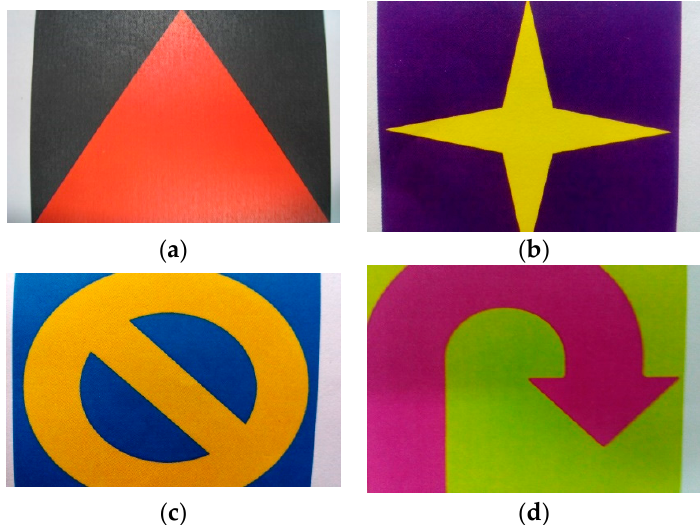
Figure 2. Predefined signs serving as motion commands: ( a ) acceleration; ( b ) deceleration; ( c ) stop; ( d ) reverse.